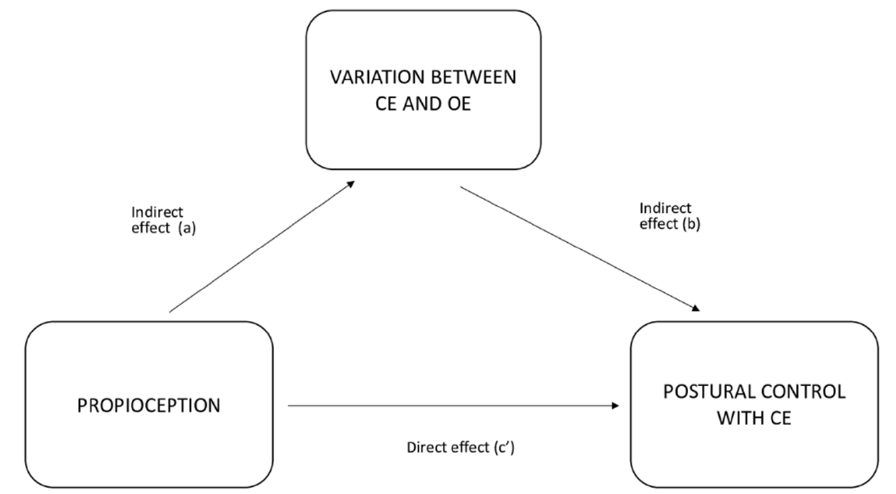
Figure 2. Mediation analysis associations.